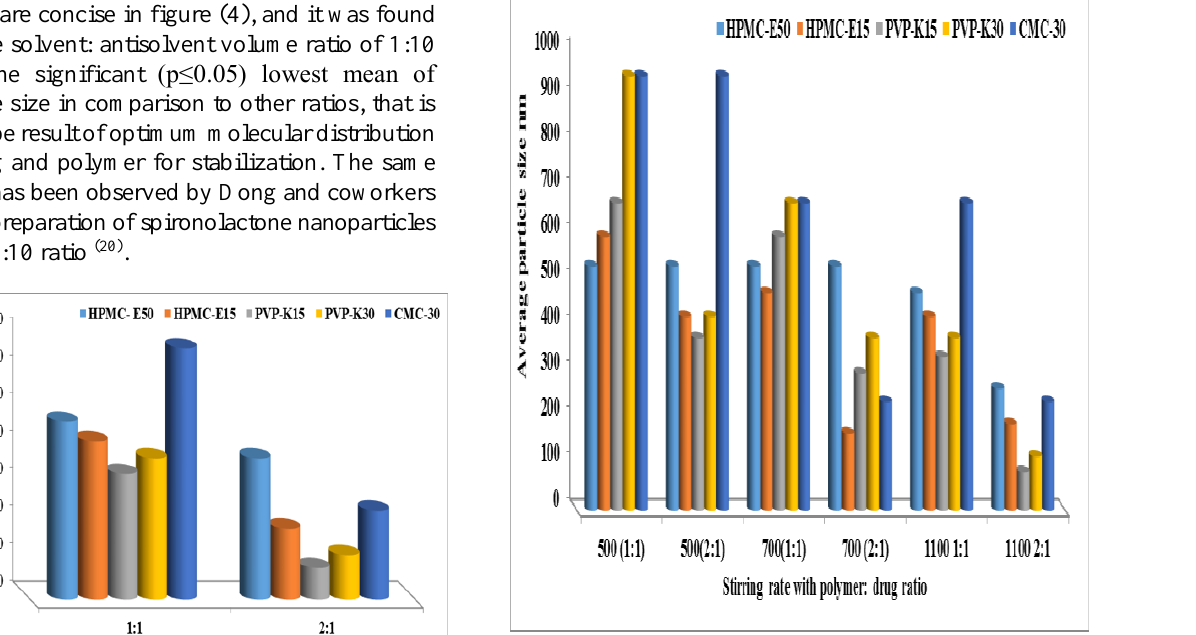
Figure 3. Effect of stirring rate on the average